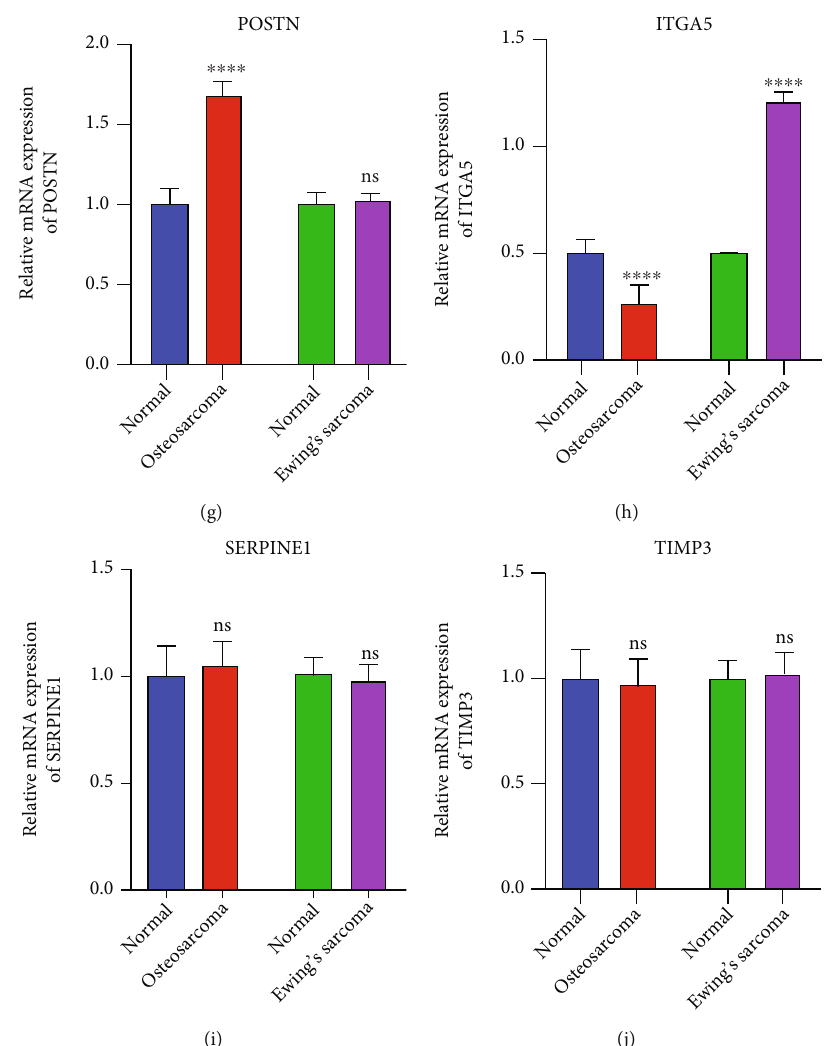
Figure 5: Validation of common oncogenic genes in osteosarcoma and Ewing ’ s sarcoma tissues. RT-qPCR results detecting the mRNA expression of (a) FN1, (b) COL1A2, (c) COL1A1, (d) ADAMTS2, (e) TIMP1, (f) THBS1, (g) POSTN, and (h) ITGA5, (i) SERPINE1, and (j) TIMP3 between osteosarcoma or Ewing ’ s sarcoma tissues and normal tissues. (k – n) Western blot showing the expression of FN1, COL1A2, and COL1A1 proteins between osteosarcoma or Ewing ’ s sarcoma tissues and normal tissues. Ns: not signi fi cant; ∗∗∗ ∗ p < 0 : 0001